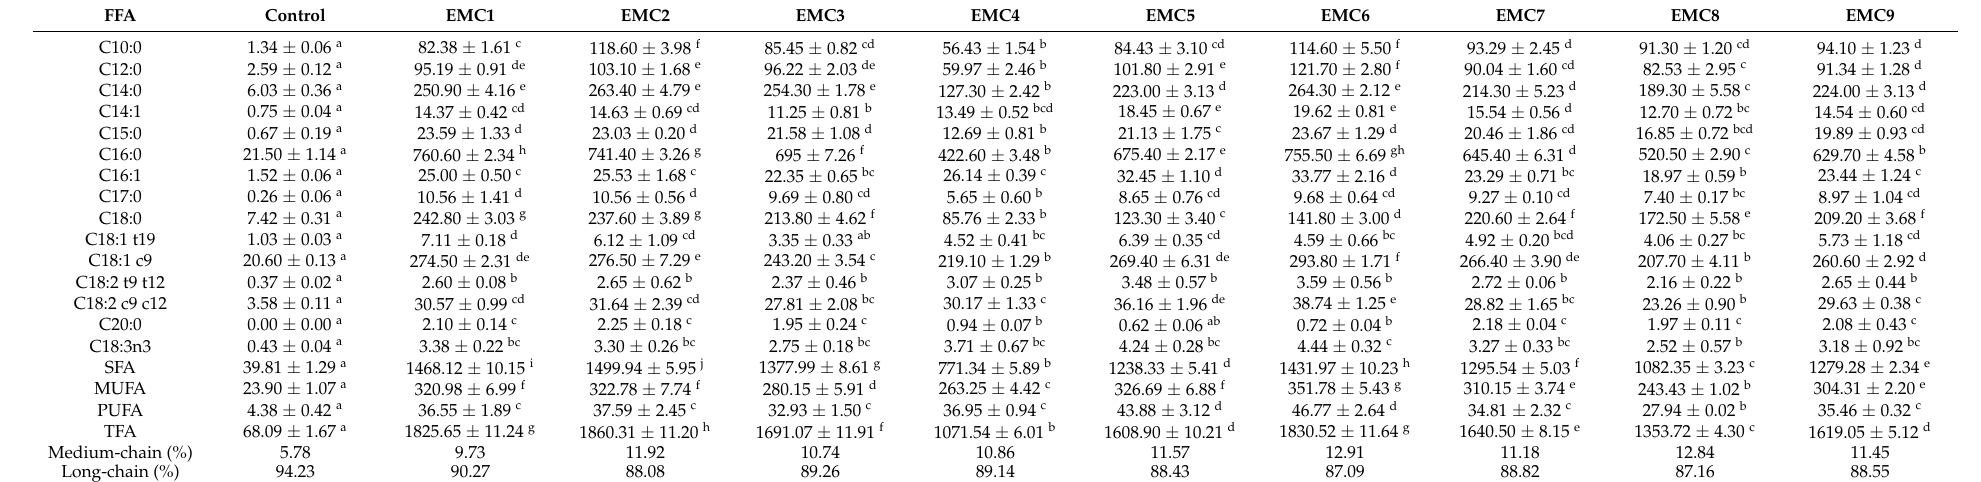
Table 3. Free fatty acid composition and their amounts (mg/100 g fat) in the analyzed